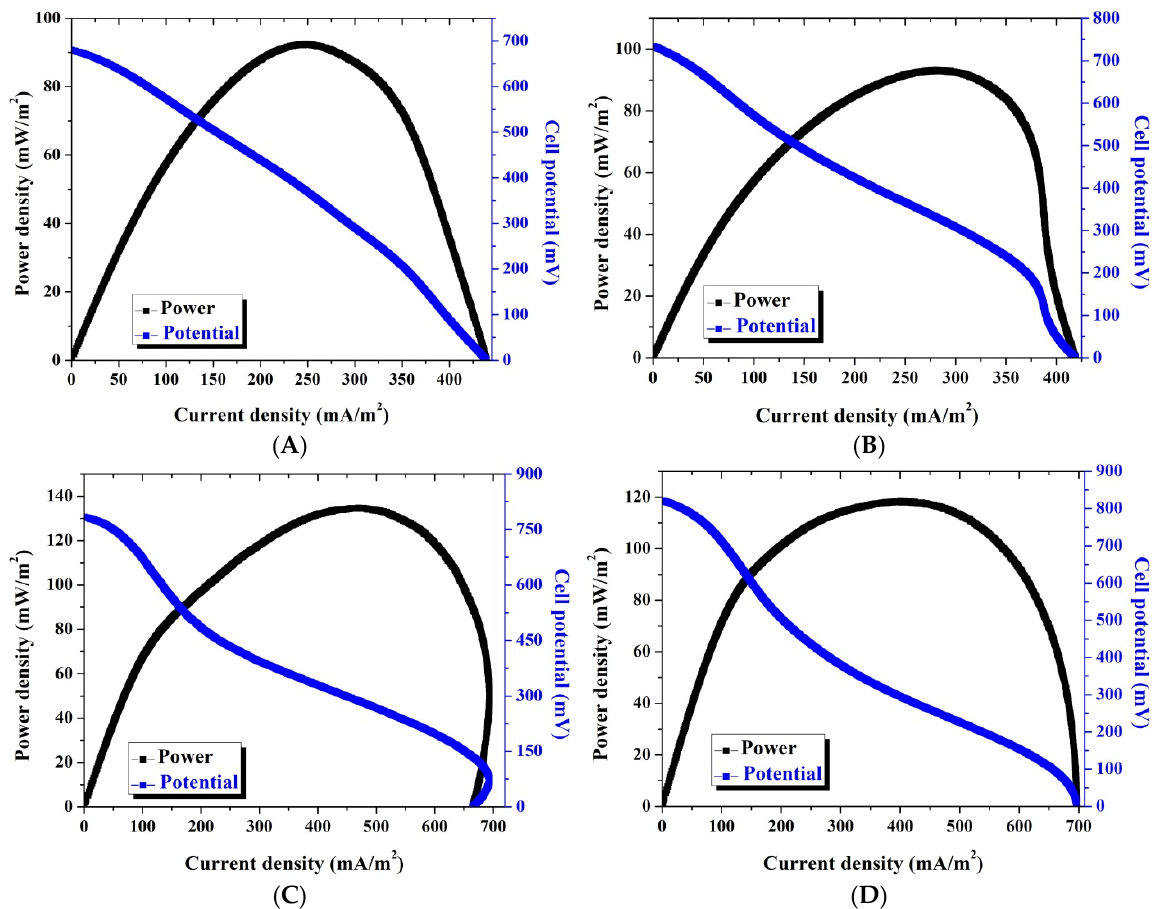
Figure 6. Polarization and power density curves of batch-mode and single-chamber MFCs using a double layer carbon nanofiber anode after 24: ( A ) 72; ( B ) 120; ( C ) and 172; ( D ) h batching time.